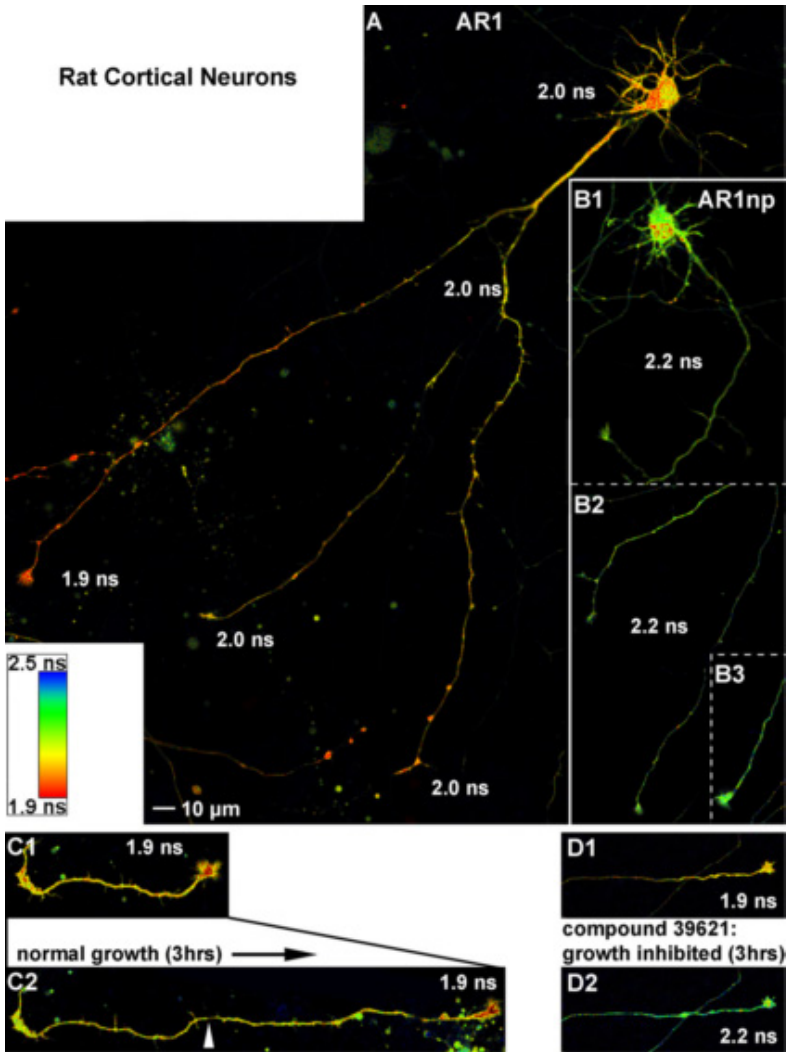
Fig. 7. Fluorescence lifetime images of AD mouse nerve growth. 35 (Permission has been granted by \The American Society for Biochemistry and Molecular Biology" through Copyright Clearance Center's RightsLink r